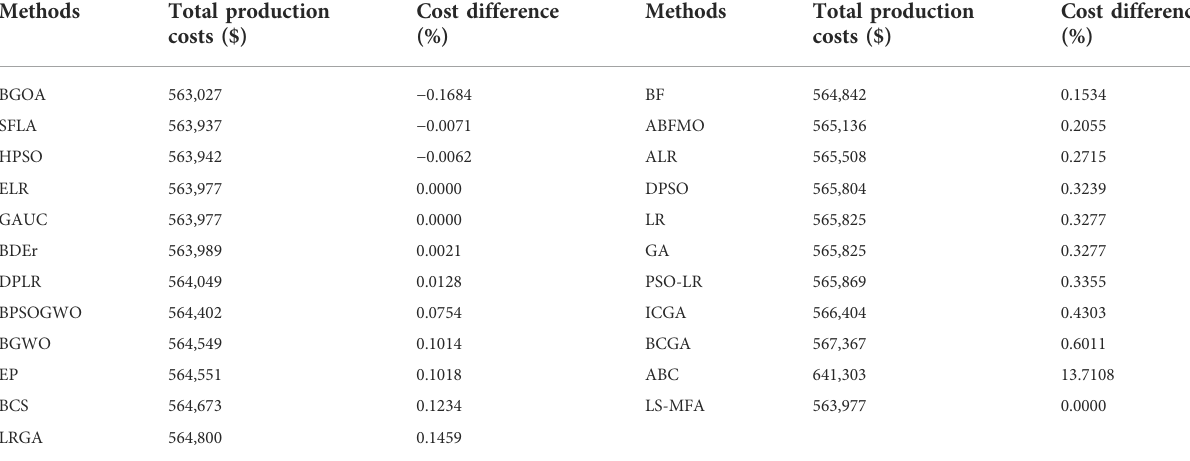
TABLE 5 Comparison of total cost with reported optimization techniques for 10-unit